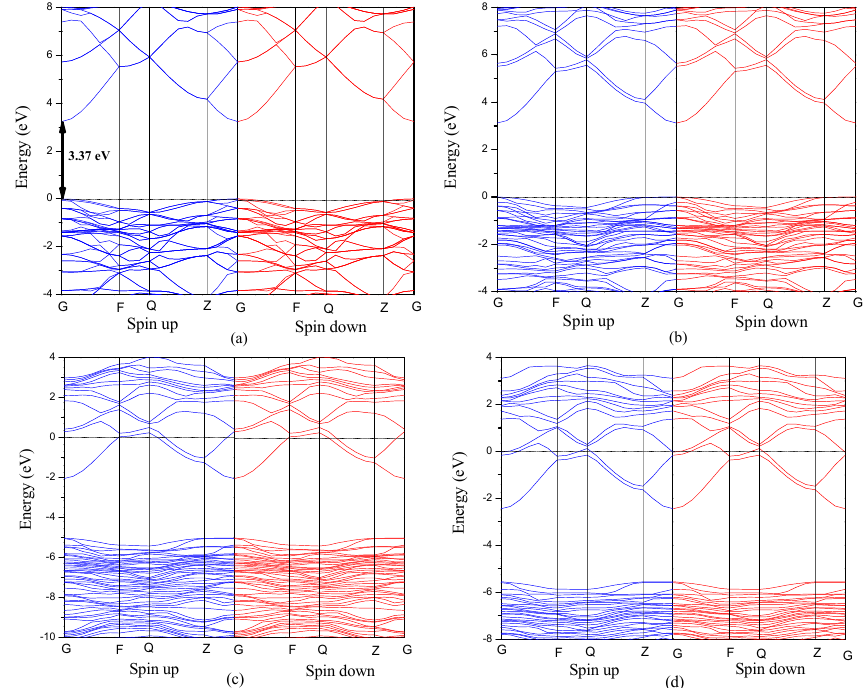
Figure 2. The band structures of ( a ) pristine ZnO bulk; ( b ) 6.25 at%; ( c ) 12.5 at%; ( d ) 18.75 at% Al-doped ZnO bulk.